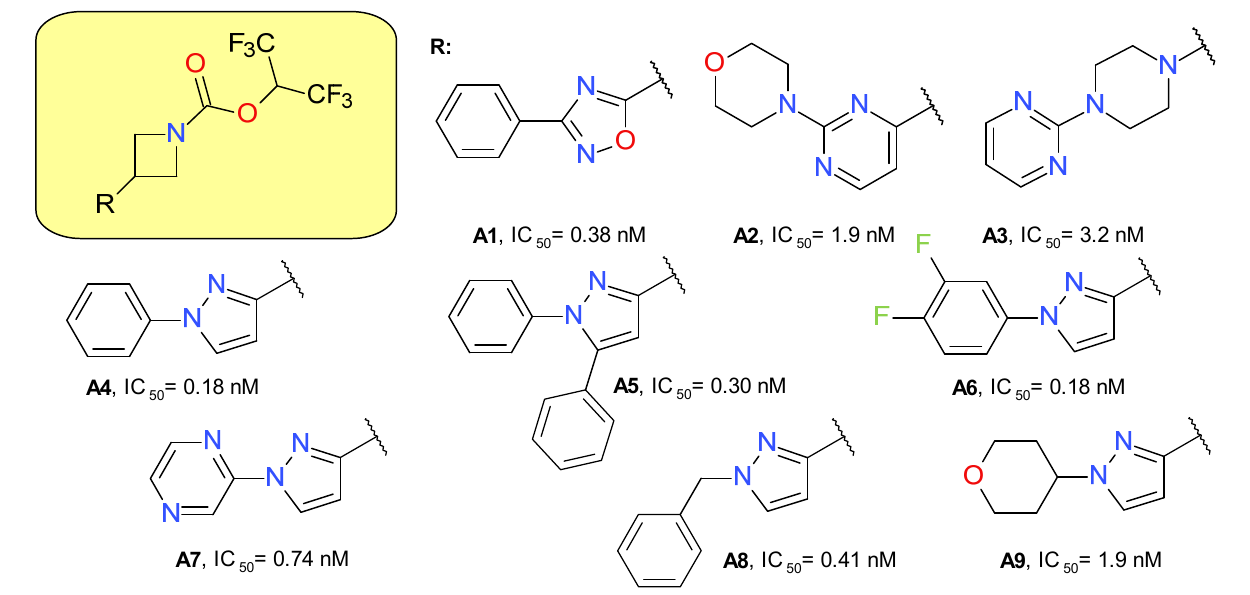
Figure 3. Irreversible MAGL inhibitors—azetidine carbamate derivatives.